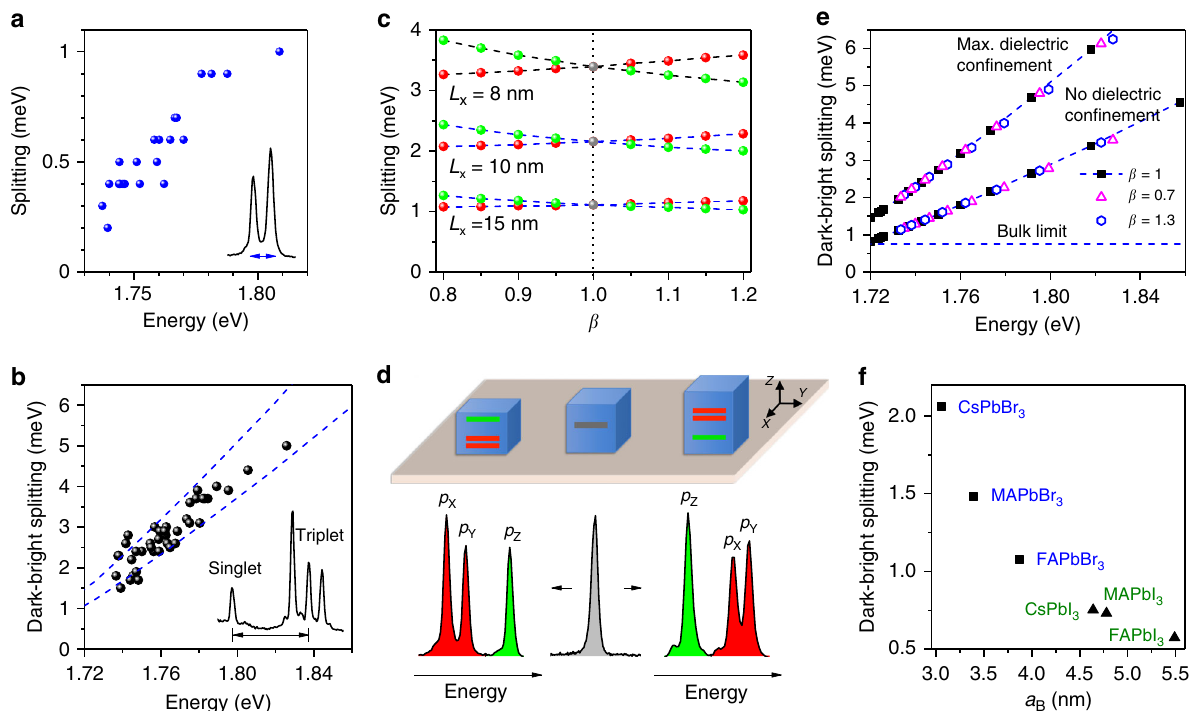
Fig. 3 Effects of quantum and dielectric con fi nements on the exciton fi ne structure. a Statistics of zero- fi eld splittings for the two-line spectra as a function of the lowest emission line energy. b Splitting at 7 T between the singlet line and the central triplet line, plotted for 40 NCs as a function of the exciton recombination energy. The dashed lines are simulations of the electron – hole exchange interaction of cubic-shaped NCs, considering the extreme values of the dielectric constant of the NC local environment: Vacuum (top line) and sapphire (bottom line), see Supplementary Note 1. c Computed evolution of the triplet splitting with the aspect ratio β of a tetragonal-shaped NC with a cubic crystal structure. The cube is elongated along the Z axis, with an aspect ratio de fi ned as L x ¼ L y ¼ L z = β . The origin of the energy scale is taken at the ground singlet level. The splittings are presented for three different NC sizes (covering the range of the explored NC sizes) and increase with quantum con fi nement. The effects of dielectric con fi nement, which enhance the fi ne structure splittings, are not taken into account in c . d Three PL spectra are chosen to illustrate the assignment of the triplet spectral structure to the NC morphology (slightly distorted tetragonal shape), assuming a cubic lattice. e Computed evolution of the exchange interaction of a tetragonal-shaped NC as a function of the exciton recombination energy, without dielectric con fi nement (lower branch) and with the maximal correction factor for the dielectric con fi nement effect, obtained when the external medium of the NC is considered as vacuum (upper branch). Data points are presented for several average NC sizes and three aspect ratios: β = 0.7 (triangles), 1 (squares), 1.3 (hexagons), in order to show the in fl uence of the NC aspect ratio on the exciton recombination energy and fi ne structure splittings. f Exchange interaction of several bulk lead halide perovskites with different chemical compositions, plotted as a function of their exciton Bohr